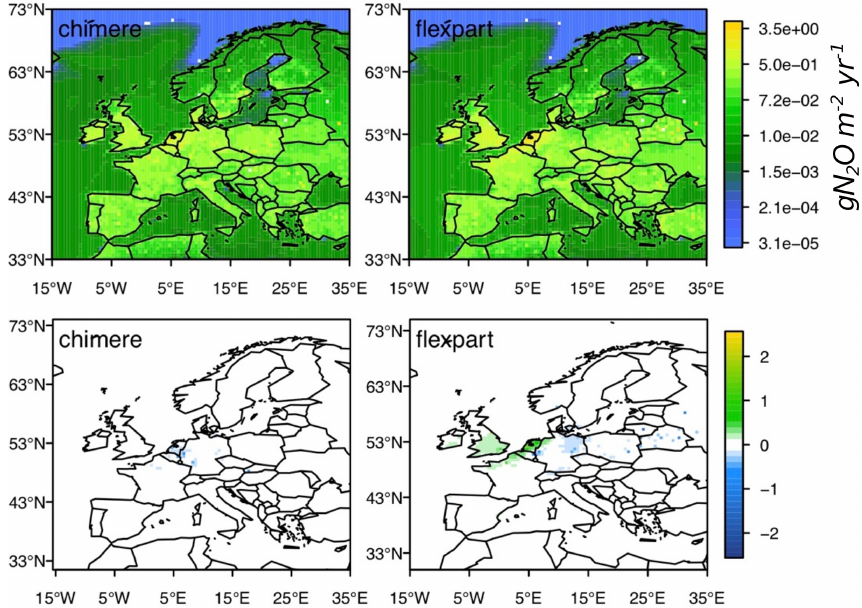
Figure 14. Posterior N 2 O fluxes averaged over 2005–2018 (gN 2 Om − 2 yr − 1 ) from two regional inversions, CHIMERE (LSCE) and FLEX- PART (NILU), shown with a log-base-2 color scale (top) and the flux increments (posterior − prior) (gN 2 Om − 2 yr − 1 ) shown on a linear color